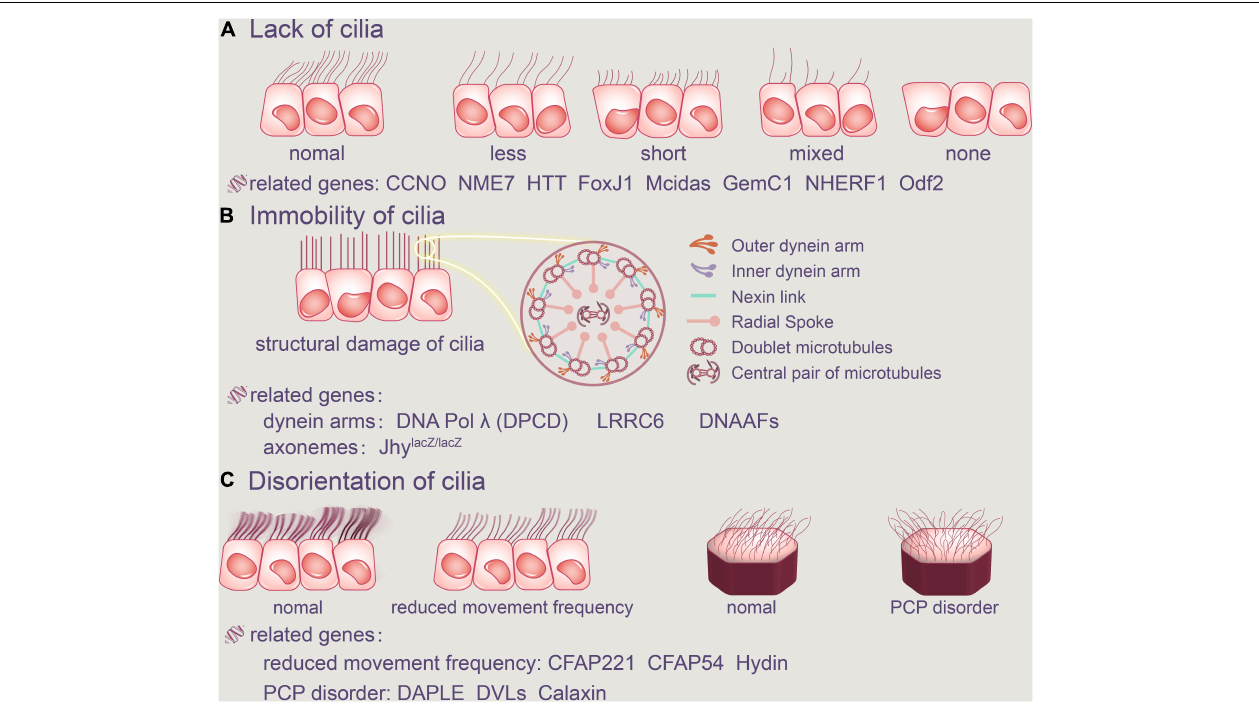
FIGURE 2 | Abnormalities of ependymal cilia. The absence of cilia, cilia immobility, and changes in planar polarity that modify the direction of the cilia’s beat are all examples of ciliary disorders. (A) Cilia loss occurs when the number of ependymal cilia decreases, their length decreases, or there are no cilia at all. FoxJ1, Mcidas, GemC1, NHERF1, Odf2, CCNO, NME7, and HTT are all related genes. (B) Furthermore, the structure of the original normal cilia is destroyed, as is the aberrant function of the dynein arms and axonemes, resulting in ependymal cilia immobility. DNAAFFs, CCDC151, and DNA Pol λ (DPCD) are all related genes. In addition, aberrant cilia function in the ependyma causes inappropriate CSF accumulation. (C) Ciliary movement frequency will be reduced by Hydin, CFAP221 and CFAP54, and regular PCP disorder will be harmed. CCNO, Cyclin O; NME7, non-metastatic cell 7; HTT, Huntington protein; LRRC6, leucine-rich repeat-containing protein 6; DNAAFs, dynein axonemal assembly factors; CFAP221, cilia-and flagella-associated protein 221; CFAP54, cilia-and flagella-associated protein 54; DVLs,